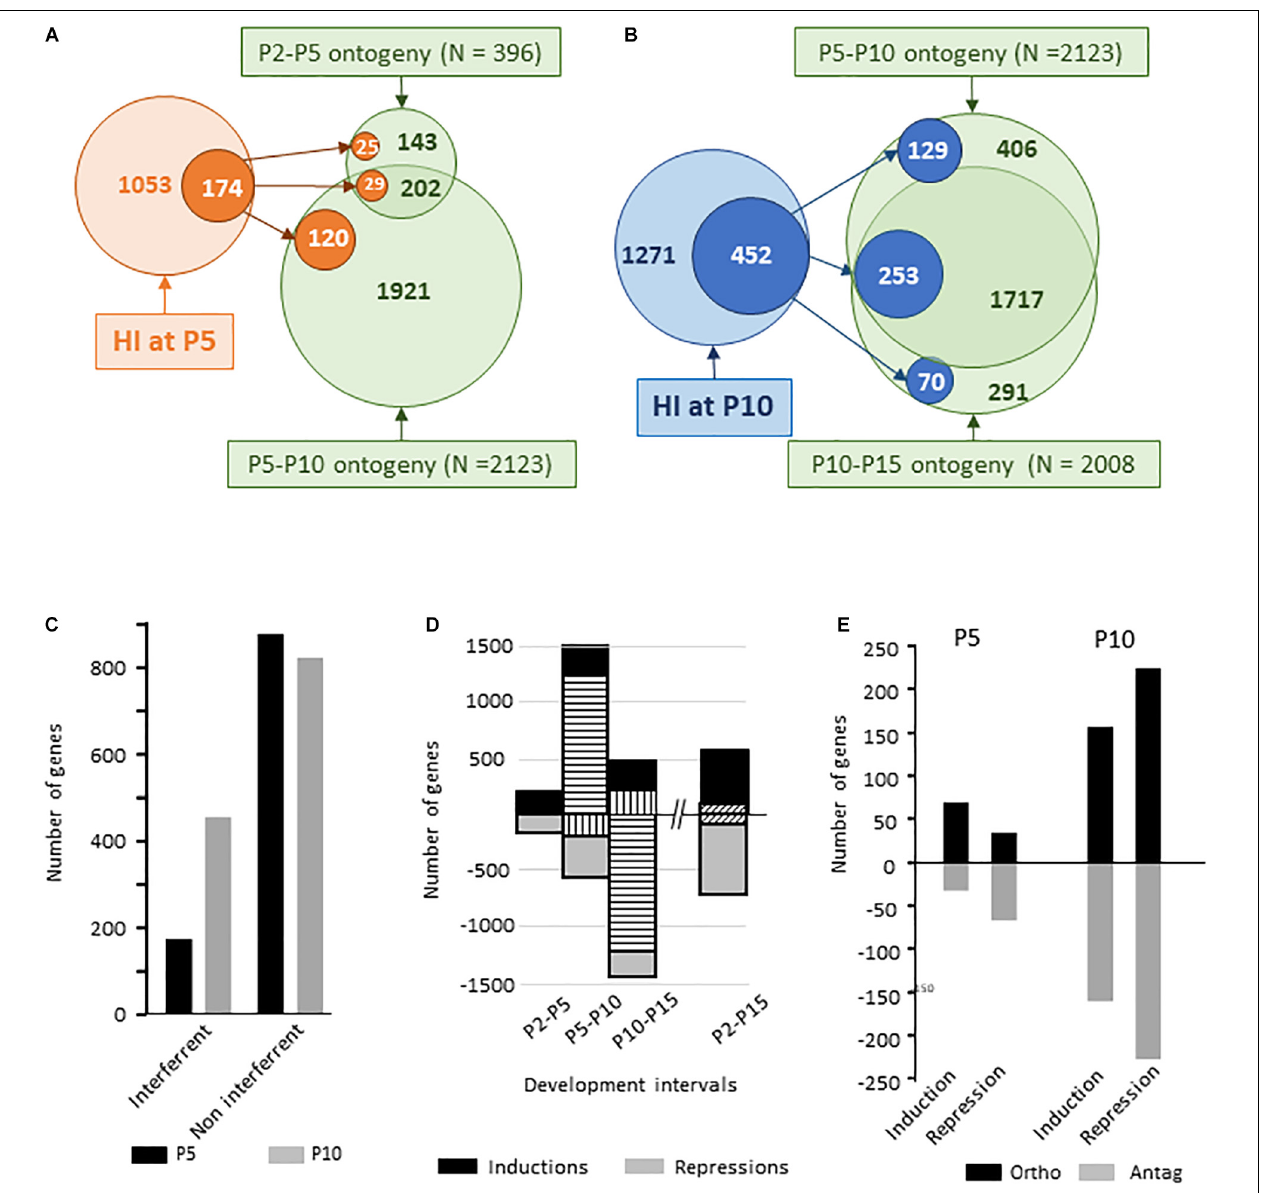
FIGURE 9 | Ontogenic regulations of gene expression in dissected hemispheres over the P2–P5, P5–P10, P10–P15, and the entire P2–P15 periods. (A) Schematic representation of HI-evoked gene expression at P5 co-incidence with previous (P2–P5) or subsequent (P5–P10) ontogenic evolution. (B) Schematic representation of HI-evoked gene expression at P10 co-incidence with previous (P5–P10) or subsequent (P10–P15) ontogenic evolution. (C) Number of genes affected by HI at P5 (black histograms) or P10 (gray histograms) also affected along with development (co-incident) or not. HI effect on genes with spontaneous development change appeared significantly enhanced in P10 mice ( χ 2 = 354, df; 1, p < 0.0001). (D) Number of genes induced (positive values) and repressed (negative values) over the different time intervals. Horizontal hatched histograms indicate the number of genes exhibiting P5–P10 increased expression followed by P10–P15 repression. Vertical hatched histograms indicate the number of genes exhibiting P5–P10 repression followed by P10–P15 increased expression. Oblique hatching indicates gene numbers having undergone opposite regulation in the intermediate intervals and P2–P15 net variation. (E) Distribution of HI effect on genes with spontaneous development change according to the direction of regulation; in the direction of (ortho) or opposite (antag) to developmental direction. Distribution were statistically different at P5 and P10 ( χ 2 = 23.8, df 3, p < 0.0001).